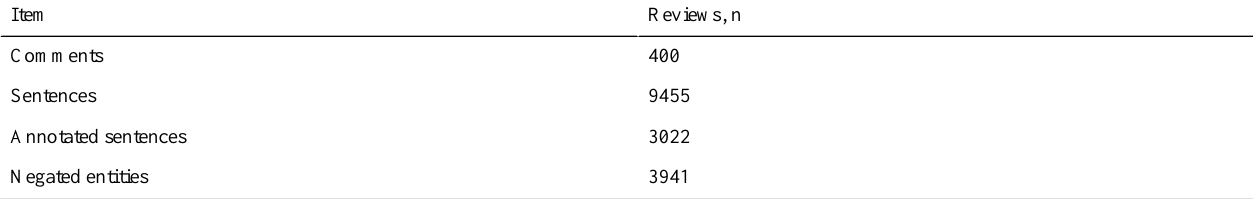
Table 11. SFU ReviewSP-NEG corpus